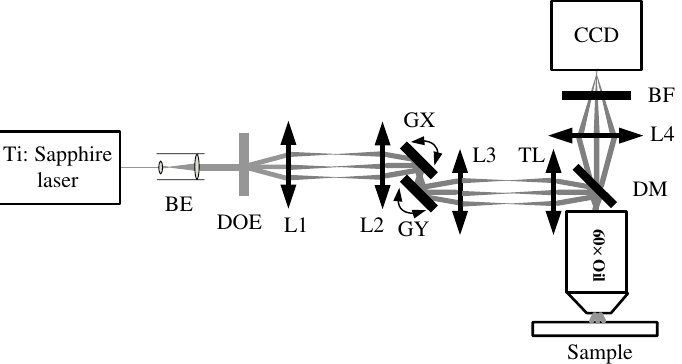
Fig. 1. Schematic of stochastic scanning multifocal multiphoton microscopic system; DOE: di®raction optical element; BE: expander; DM: dichroic mirror; TL: tube lens; GX, GY: galvo mirrors; L1 – L4: lenses; BF: block